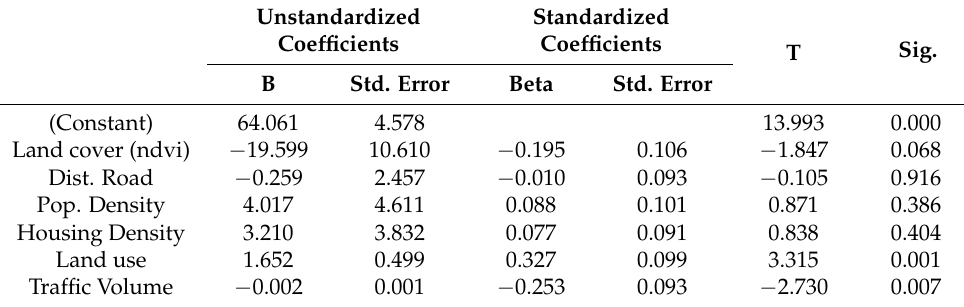
Table 6. Coefficients of Regressions.